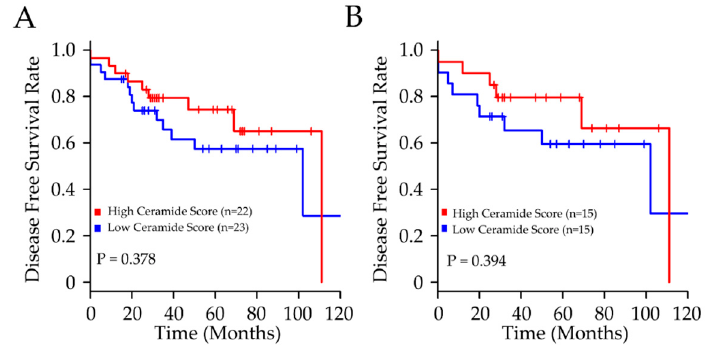
Figure A1. Elevated ceramide levels in primary TNBC samples are not prognostic for patient disease-free survival. Kaplan-Meier curves of TNBC patients stratified based on ( A ) median ceramide abundance or ( B ) highest vs. lowest tertile of sphingomyelin abundance (log rank test).